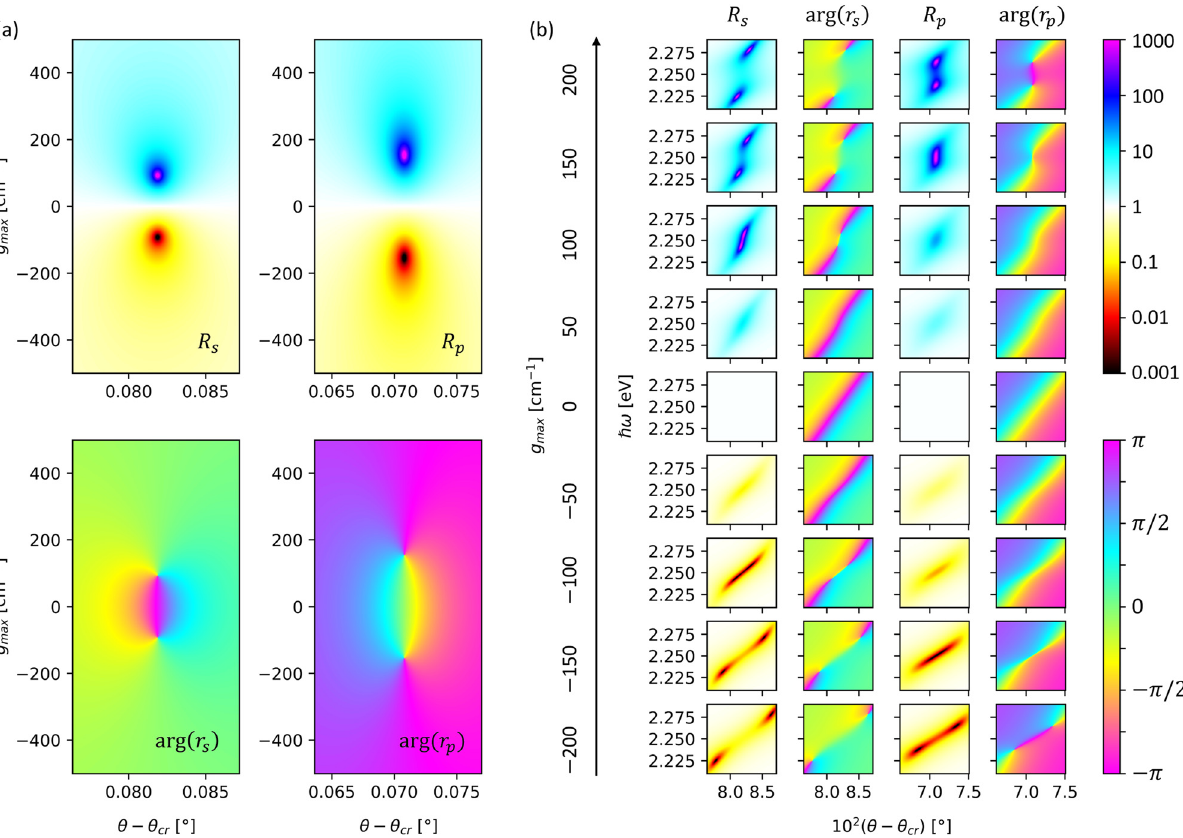
Figure 8: Total internal reflection with evanescent coupling to a thin layer with either gain or loss. (a) Dependence of the reflectivity R s , p and the re fl ected phase arg ( r s , p ) on the incidence angle θ (horizontal axis) and on the gain coef fi cient g max (vertical axis) at a fi xed photon energy of 2.25 eV. Negative g max means an effective loss. (b) Frequency – momentum distributions of R s , p and arg ( r s , p ) at various g max , showing the birth of singularities in the regime of both gain (divergent ampli fi cation) and loss (perfect